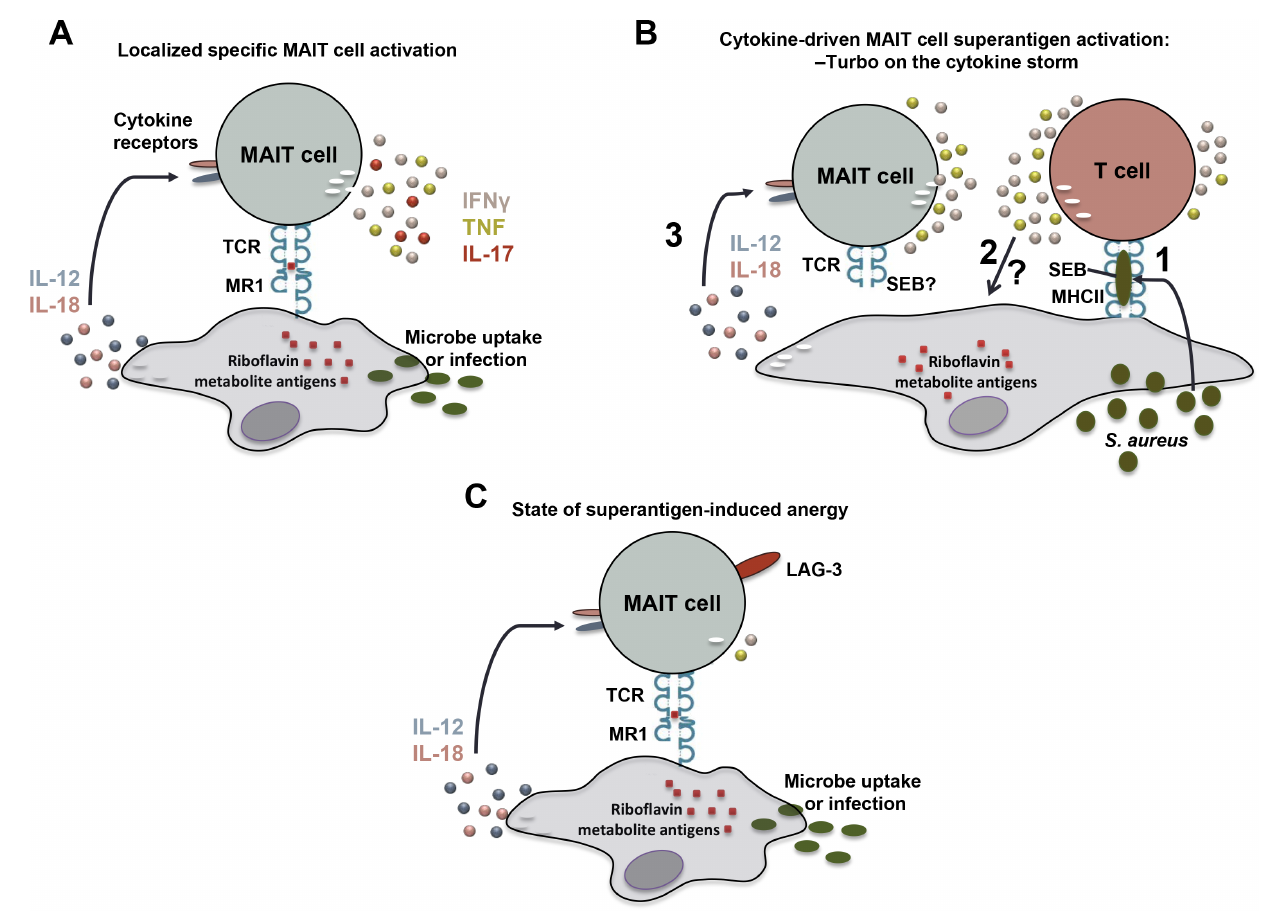
Fig 1. Deception and diversion of MAIT cell responses by bacterial superantigen. (A) Mucosa-associatedinvariantT (MAIT) cells recognizebacterialriboflavinmetabolites presented by major histocompatibility complexclass-Ib related protein 1 (MR1) molecules.This responseis enhancedby interleukin12 (IL-12) and interleukin18 (IL-18) producedby the antigen-presentingcell. (B) Staphylococcal enterotoxin B (SEB) activates a cytokine storm by conventional T cells, which in turn strongly activates MAIT cells. This MAIT-cell response enhancesthe already ongoingcytokine storm. There is also some contribution of direct SEB effects on a small fraction of MAIT cells via their T- cell receptor (TCR). (C) After the cytokine storm, MAIT cells become hyporesponsive and this anergic state dependsat least partly on the inhibitoryreceptor lymphocyte-activationgene 3